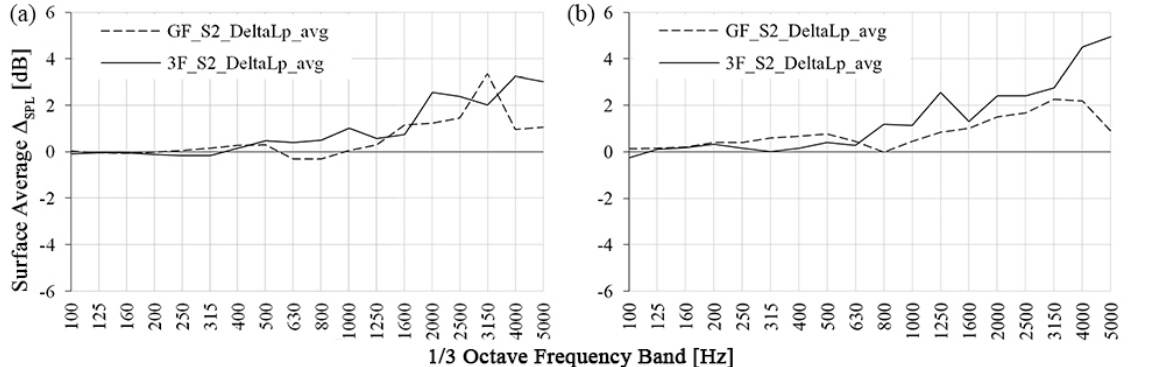
Figure 13. Δ SPL calculated between SPL on the glass surfaces of windows averaged over all the microphone positions. Ground floor (dashed line) and third floor (solid line). Source position in S2 , as it is in Figure 4. ( a ) Δ SPL = B1 SPL − C1 SPL ; ( b ) Δ SPL = B2 SPL − C2 SPL . Configurations B1, B2, C1, C2 are as they are in Figure 3.